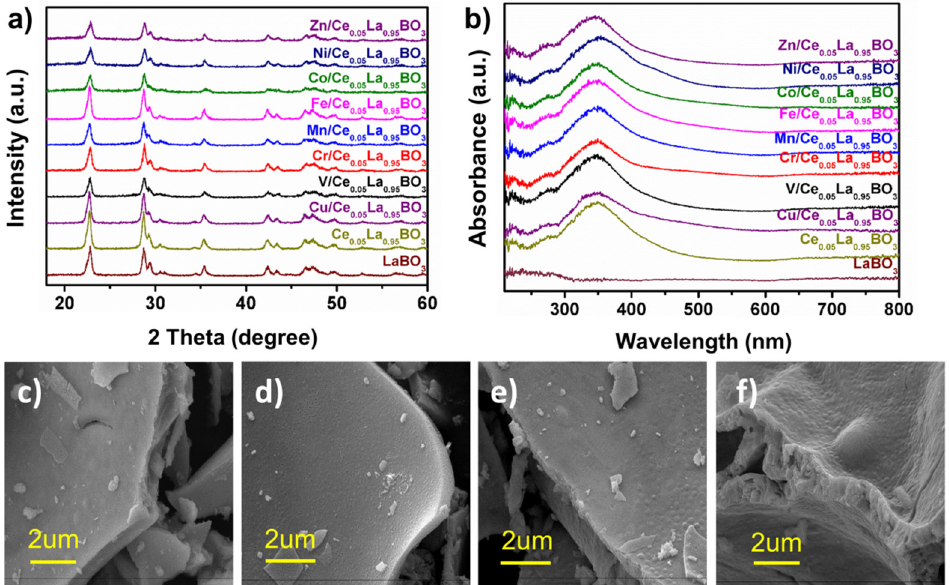
Figure 2. ( a ) Powder XRD patterns and ( b ) UV–visible diffuse reflectance spectra for LaBO 3 , Ce 0.05 La 0.95 BO 3 , and TMs/Ce 0.05 La 0.95 BO 3 ; SEM images of the ( c ) Cu/Ce 0.05 La 0.95 BO 3 , ( d ) Ni/Ce 0.05 La 0.95 BO 3 , ( e ) Co/Ce 0.05 La 0.95 BO 3 , and ( f ) V/Ce 0.05 La 0.95 BO 3 catalysts.